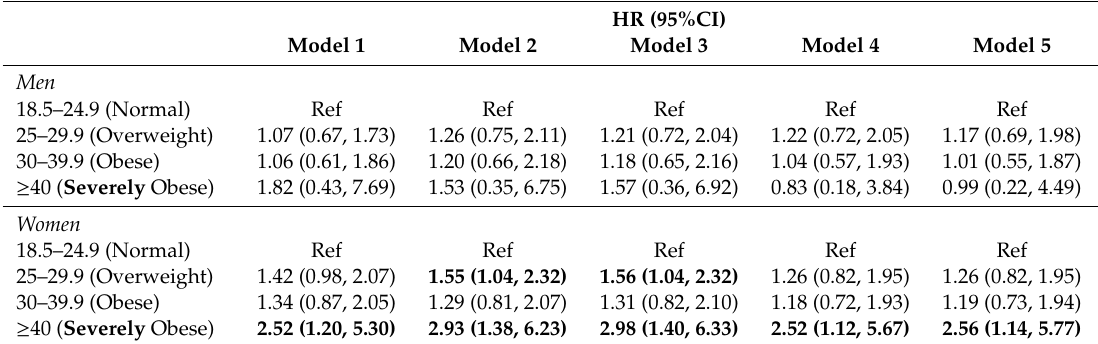
Table 4. Hazard ratio (HR) and 95%CI for health-related job loss (HRJL) by categories of body mass index (BMI), for men and women. (Bold type denotes statistical significance at the p < 0.05 level). HR (95%CI) Model 1 Model 2 Model 3 Model 4 Model